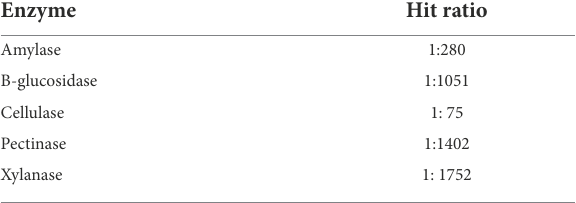
TABLE 2 Hit ratios of the screened hydrolytic enzymes. Enzyme